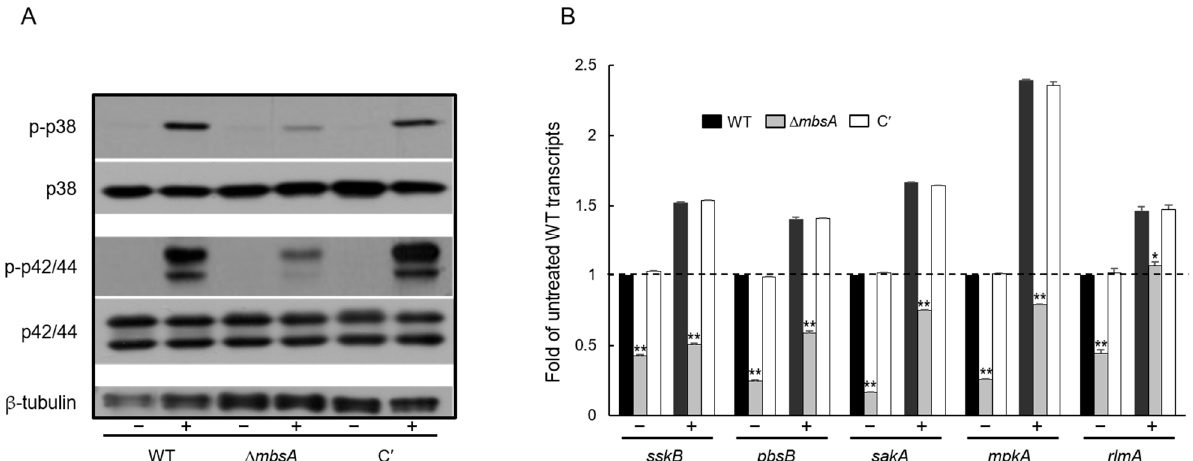
Figure 4. MbsA positively affects the SakA MAPK pathway. ( A ) Conidia of the indicated strains were grown for 14 h in MMY medium and treated with 200 µg/mL of Calcofluor White (CFW) (+) or not ( − ). Aliquots of cell were harvested after 20 min and used to prepare total protein extracts. Protein extracts were analyzed by immunoblotting with anti-phospho-p38 and anti-phoshpo-p42/44 antibodies. ( B ) mRNA levels of SakA MAP kinase pathway-related genes in WT, Δ mbsA , and C ′ strains analyzed by RT-qPCR at the same culture condition. The ef1 α gene as the endogenous control. Statistical differences between strains were evaluated with ANOVA test: ** p < 0.01, * p < 0.05.